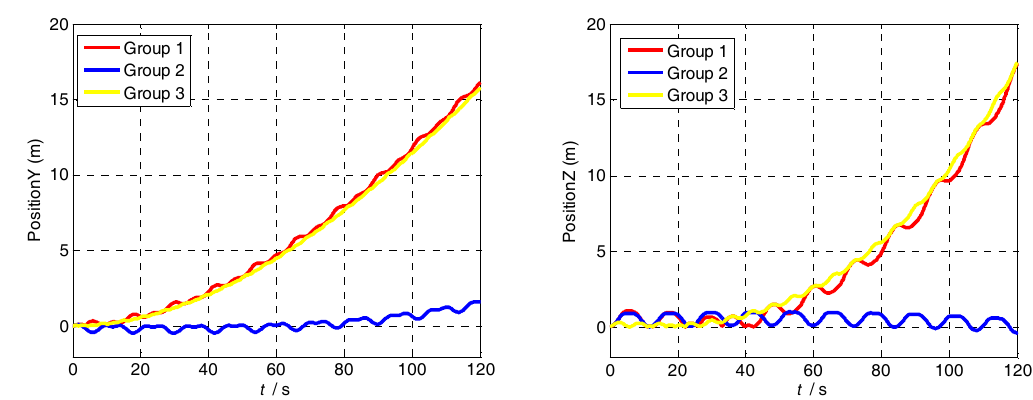
Figure 8. The positioning errors simulation curves of the three groups.